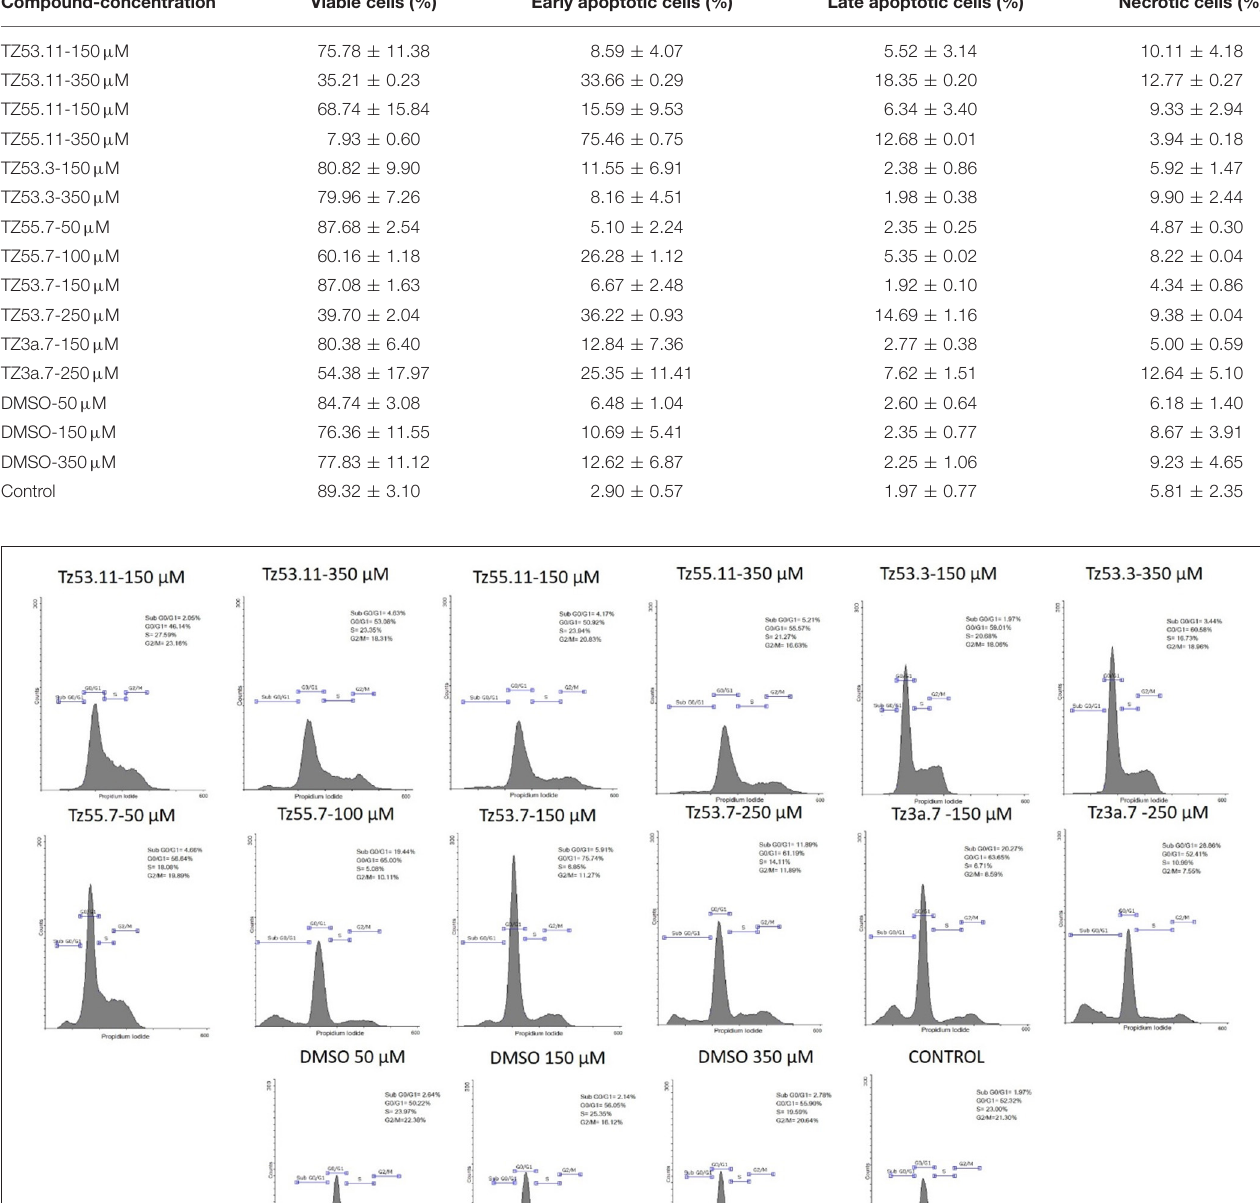
(Miettinen et al., 2012). Expression of VEGFR2 protein was also detected in different tumor cells, like: human colorectal, breast and non-small cell lung cancers (Holzer et al., 2013), hemangiomas, angiosarcomas, malignant melanoma and diffuse large B-cell lymphoma (Miettinen et al., 2012). It was